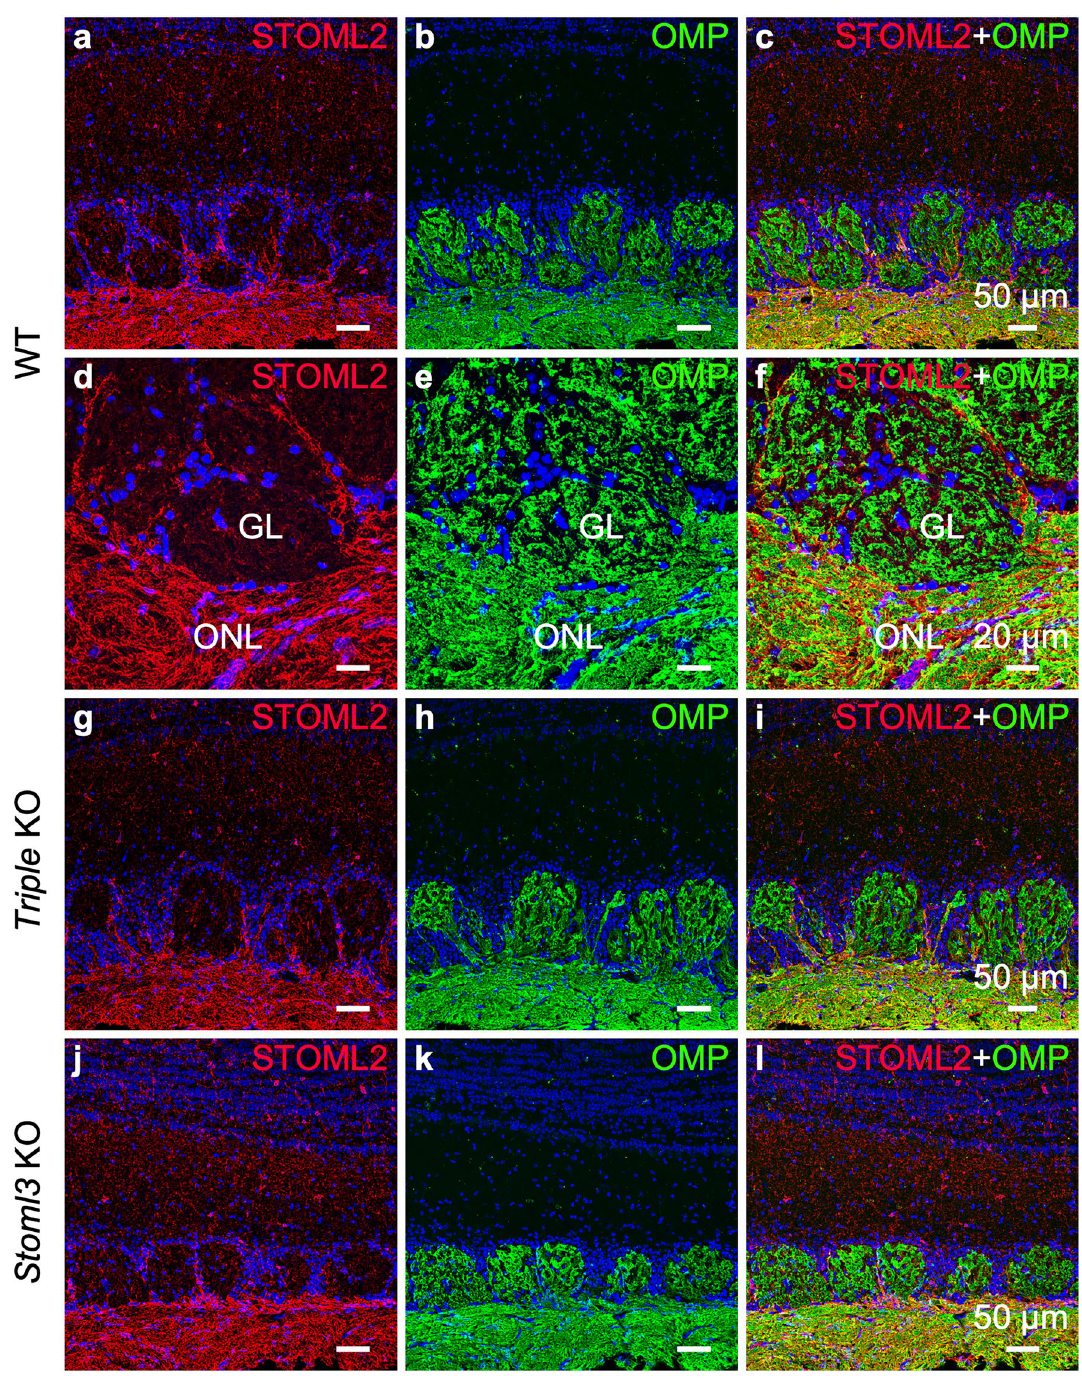
Figure 7. STOML2 is expressed in ensheathing cells but not in olfactory sensory neuron axons. Confocal micrographs of coronal sections of the OB of WT ( a – c ), Triple KO ( g-i ), and Stoml3 KO ( j-l ) mice double- stained with anti-STOML2 (red) and anti-OMP (green) antibodies. In all three mice models, STOML2 has a uniform and strong expression in the external nerve layer of the OB while is weakly present in more internal layers including the glomeruli. ( d-f ) Higher magnification of OSN axon bundles shows the localization of STOML2 in ensheathing cells. Nuclei were stained with DAPI